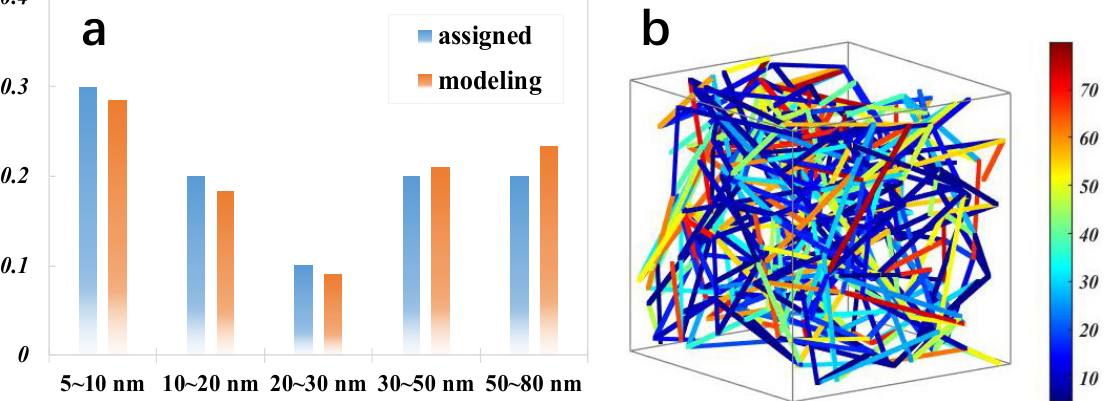
Figure 2. Construction of porous media with assigned spatial pore network attributes ( a ): Pore size distribution; ( b ): Spatial pore structure.